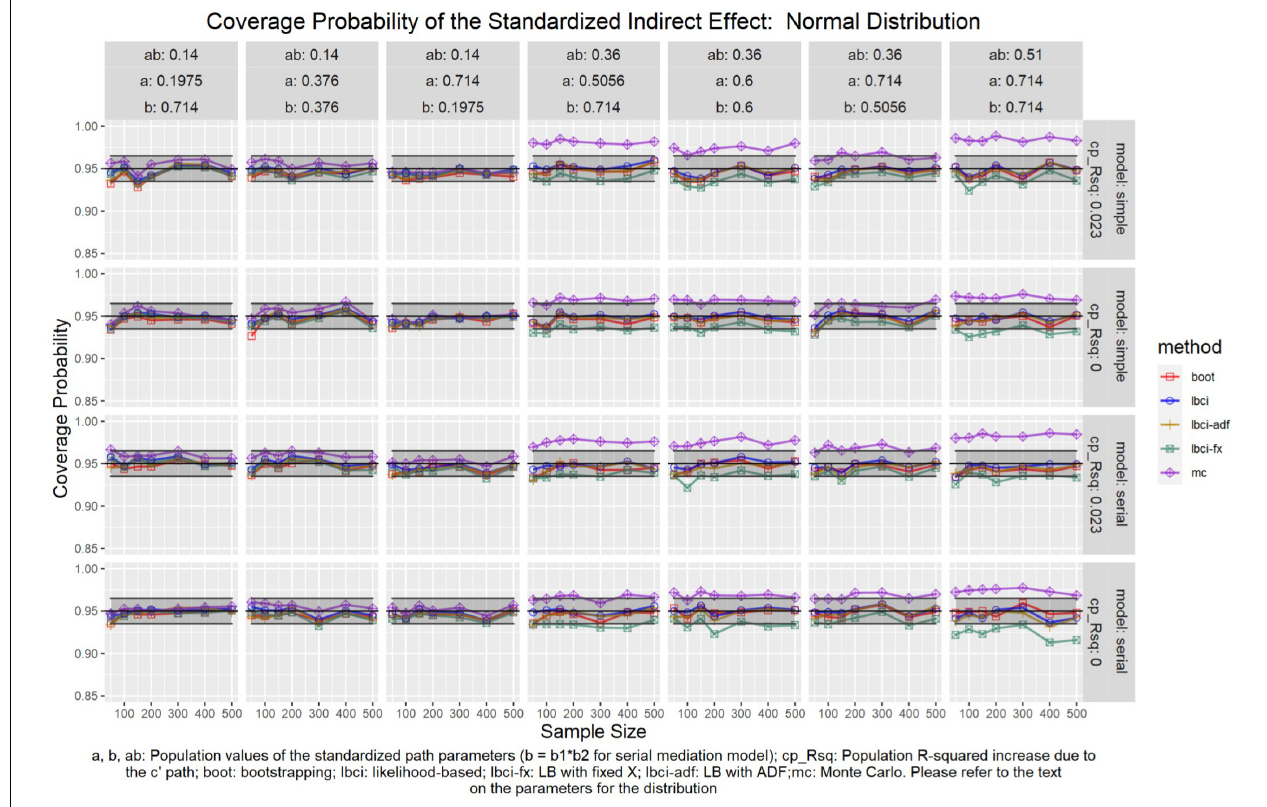
FIGURE 10 | Normal Distribution (Standardized Indirect Effect). a, b, ab: Population values of the standardized path parameters (b = b1 × b2 for serial mediation model); cp_Rsq: Population R-squared increase due to the c (cid:48) path; boot: bootstrapping; Ibci: likelihood-based; Ibci-fx: LB with fixed X; Ibci-adf: LB with ADF;mc: Monte Carlo. Please refer to the text on the parameters for the